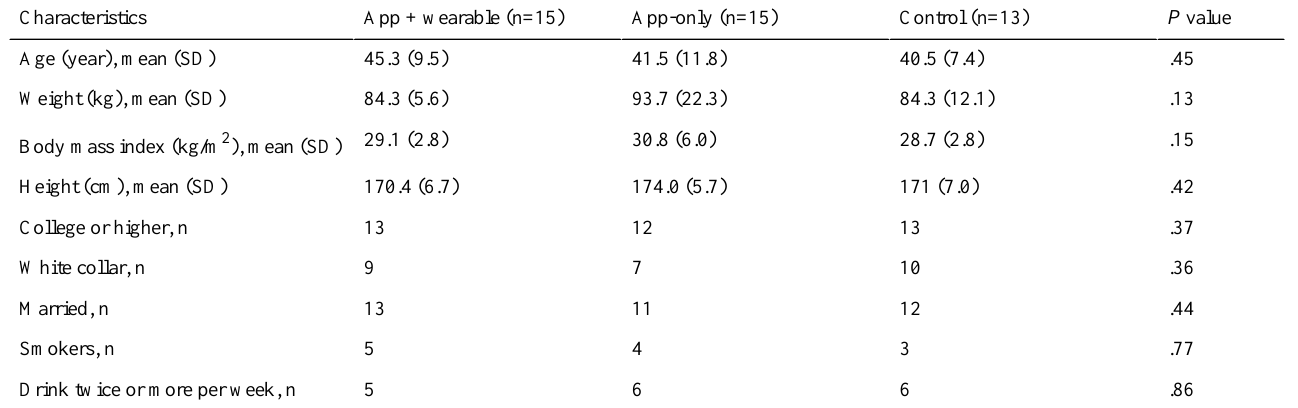
Table 1. General characteristics of study participants.